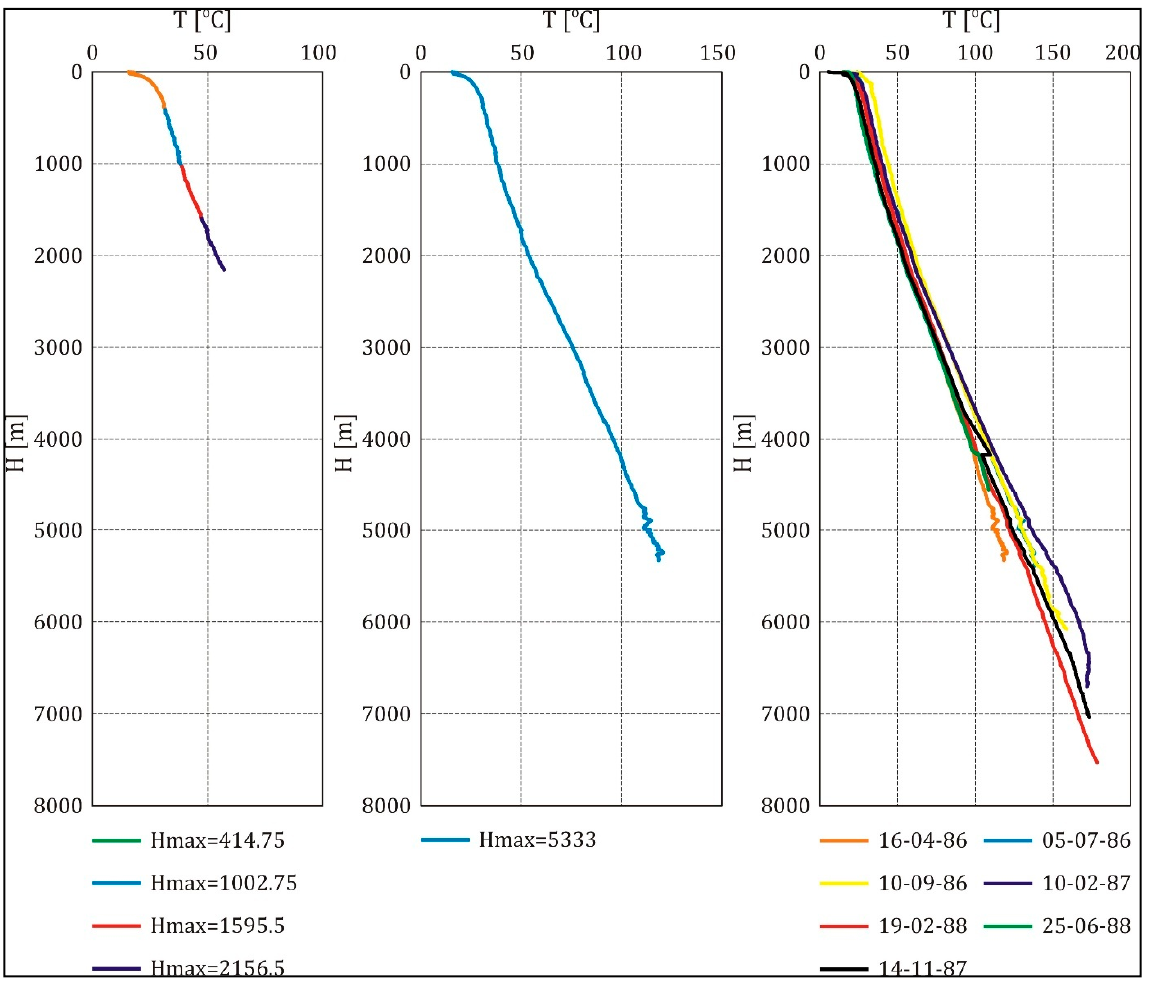
Figure 5. Plots of temperature changes vs. depth in very deep borehole, K ‐ 1, south ‐ eastern Poland; left and middle plots—results of the section temperature measurements on 16 April 1988, Hmax [m]—section bottom hole depth; right plot—results of the temperature measurements on different dates.